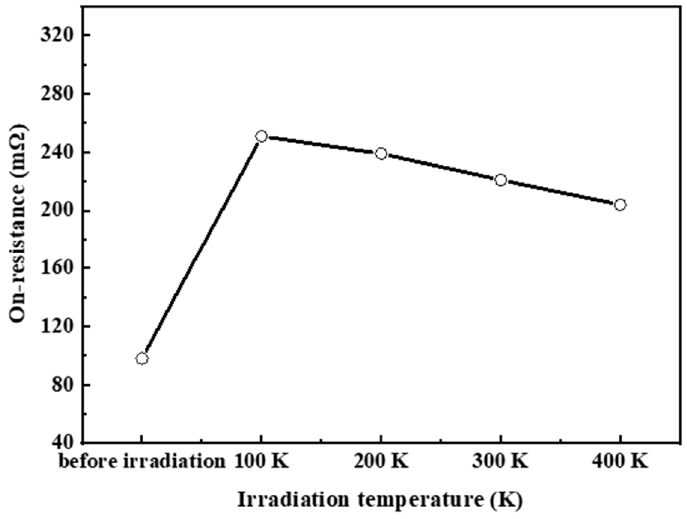
Figure 3. The plot of on-resistance against the irradiation temperature for 4H-SiC diodes.